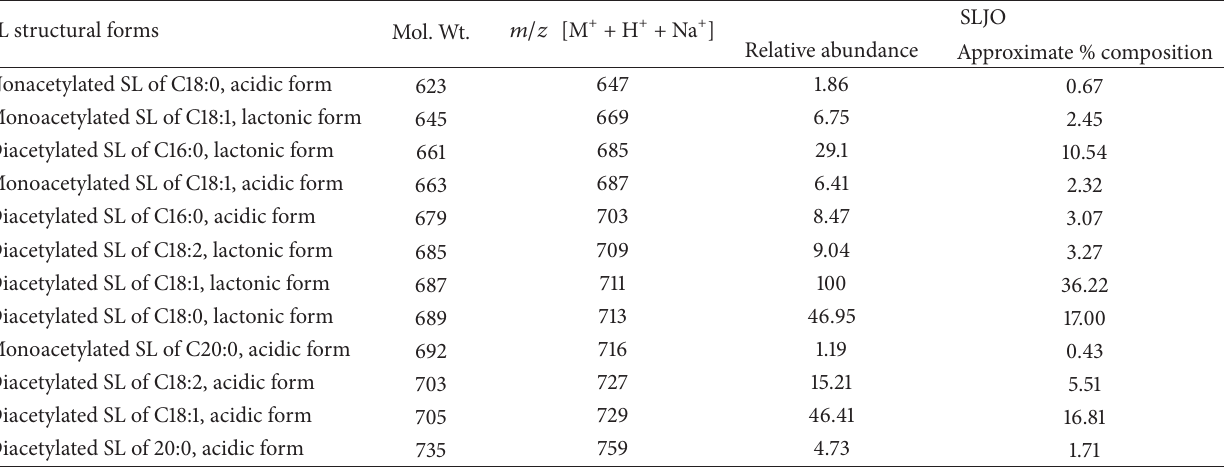
Table 3: Comparative data on structural composition of